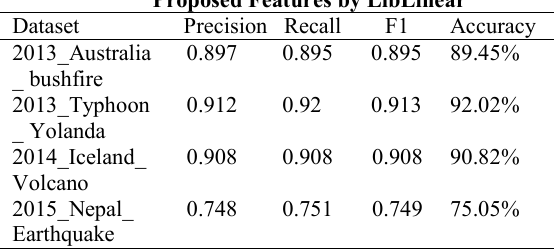
Table 5. Classification Results using Proposed Feature Extraction Model Proposed Features by LibLinear